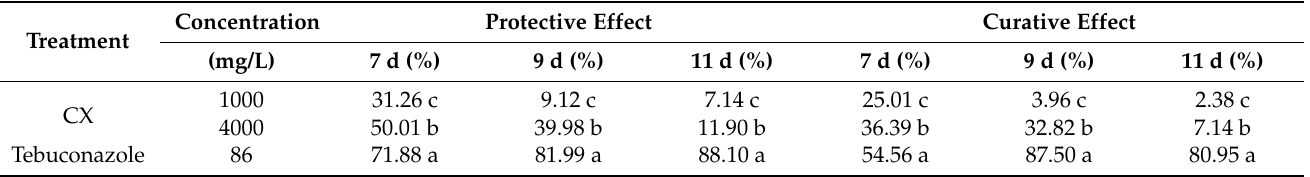
Table 3. Control effect of CX extract on Fusarium graminearum by pot trial.